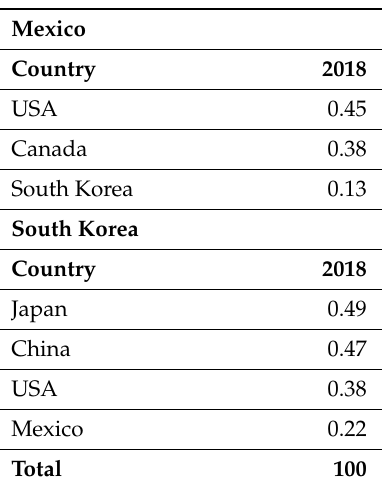
Table 10. Grubel-Lloyd Index